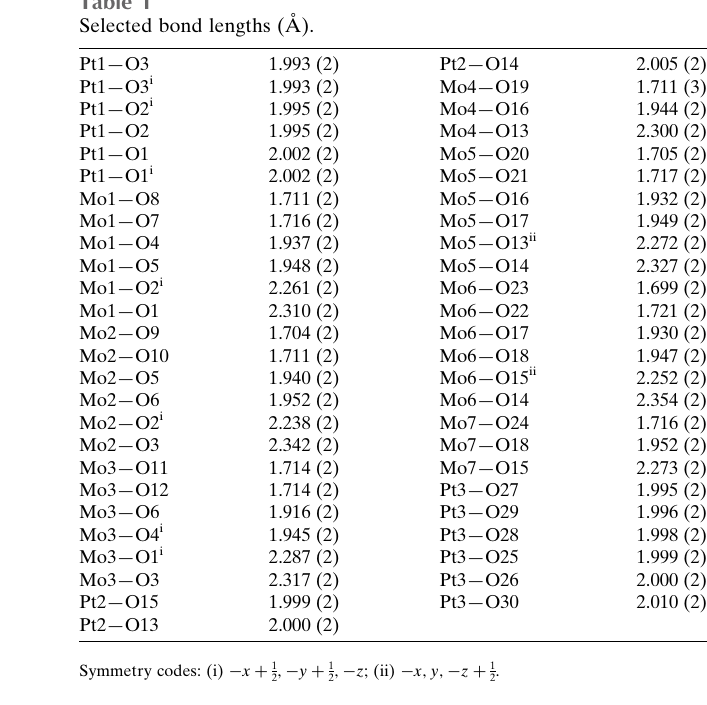
Figure 1 The structures of ( a ) anion A and ( b ) anion B with the atom labelling and displacement ellipsoids at the 50% probability level. [Symmetry codes: (i) (cid:2) x + 1 , (cid:2) y + 1 , (cid:2) z ; (ii) (cid:2) x , y , (cid:2) z + 1 2 2